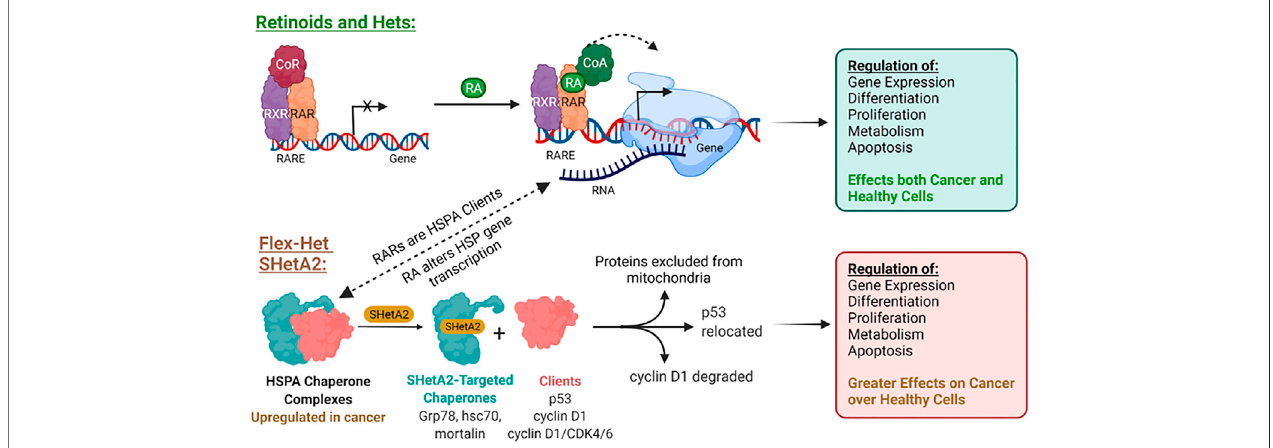
FIGURE 2 | Differences in mechanisms of RA and the Flex-Het